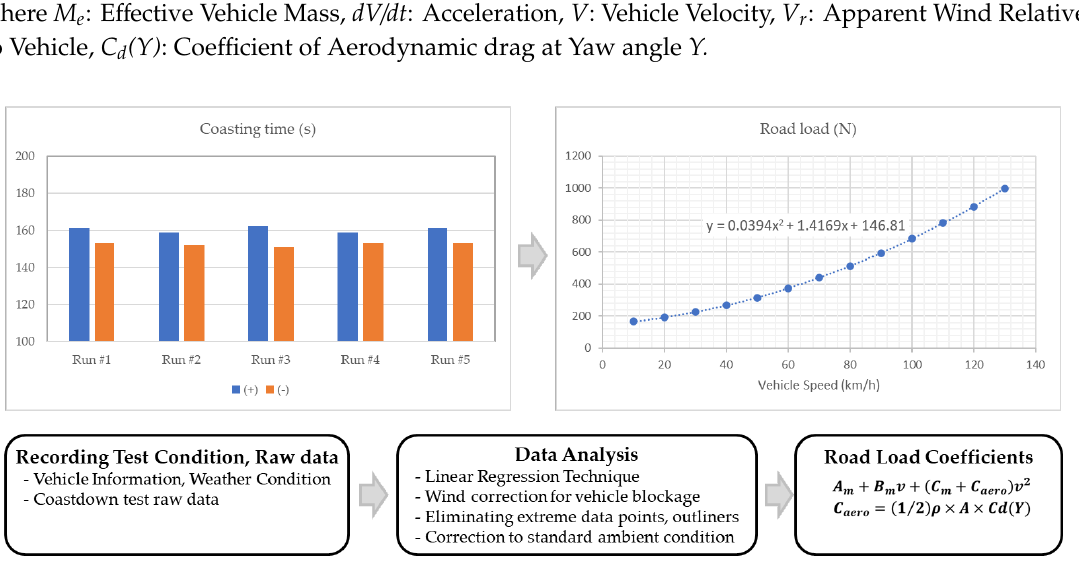
Figure 5. Worldwide harmonized light vehicles test procedure (WLTP) road load determination via coastdown method .